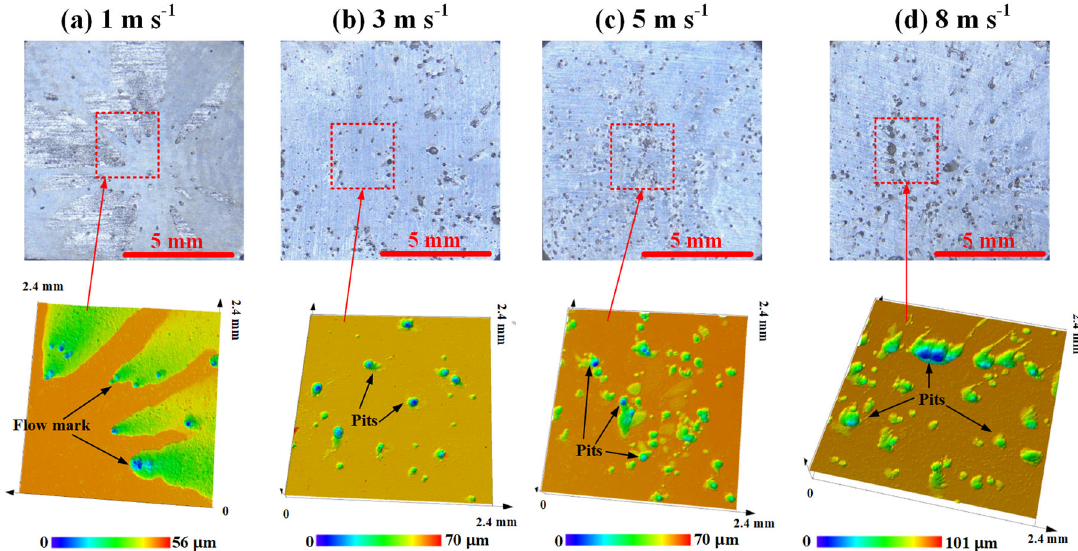
Fig. 4 Photos and local 3D pro fi les of the steel tested in pure natural seawater with rust layers removed. a 1 m s − 1 , b 3 m s − 1 , c 5 m s − 1 , and d 8 m s − 1 .